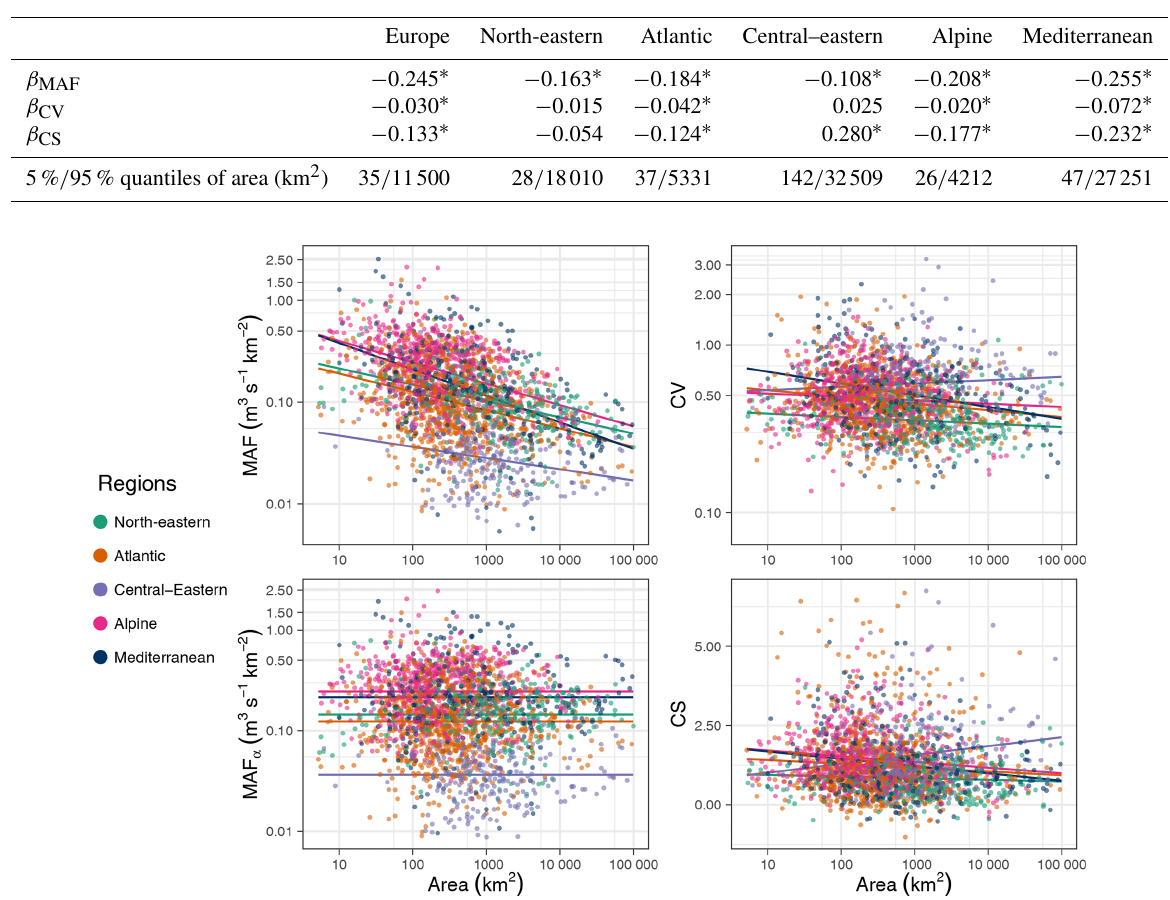
Figure 4. Mean annual specific flood (MAF), normalized mean annual specific flood (MAF α ), CV, and coefficient of skewness (CS) plotted against catchment area (km 2 ). Colours indicate region. Lines are regression lines for each of the